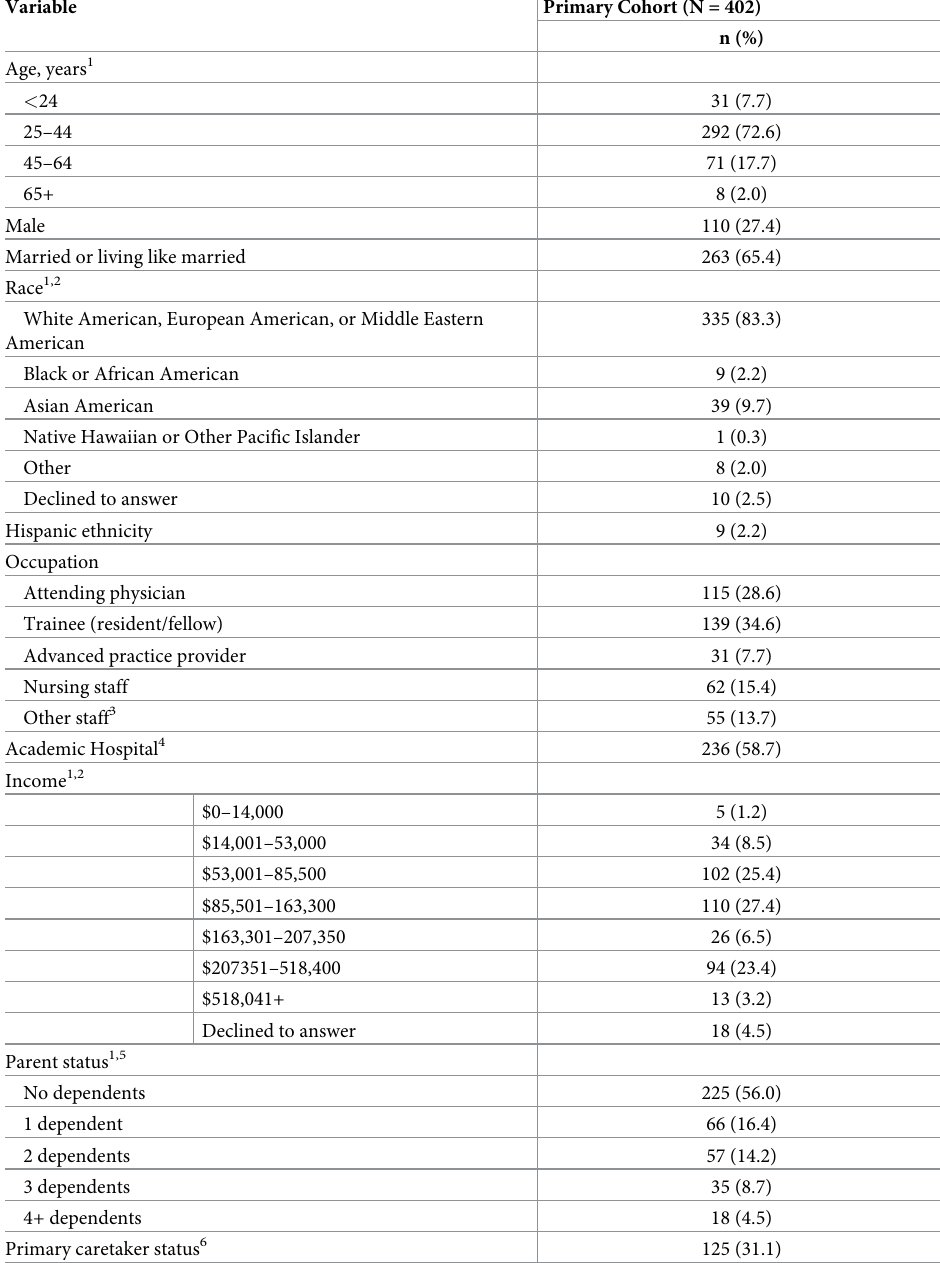
Table 1. Enrollment questionnaire for participants included in primary